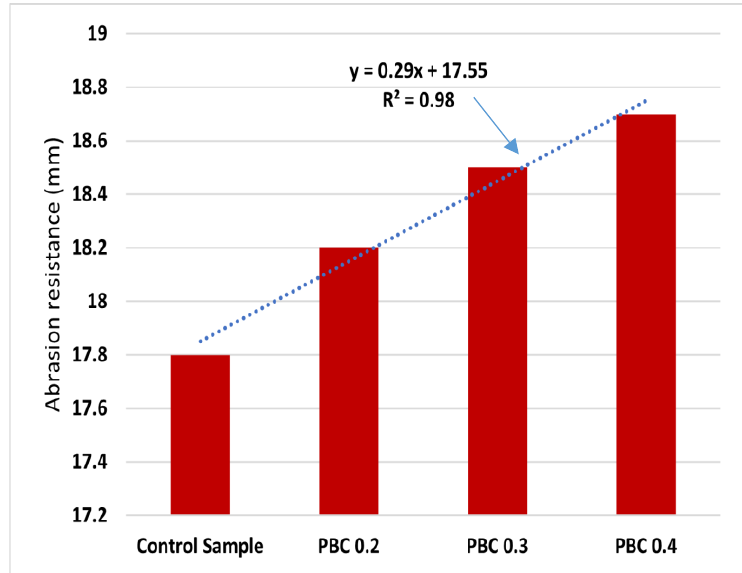
Figure 9. Abrasion resistance of CCF IPB at 28 days.